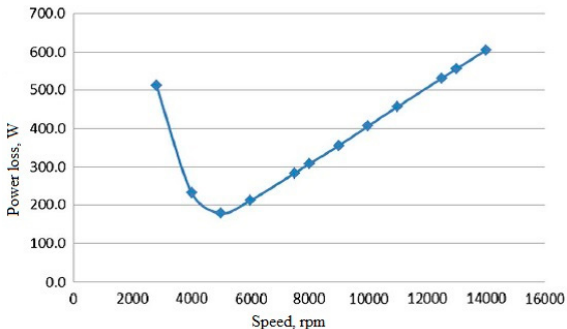
Figure 10. Copper loss under continuous power with speed [68].